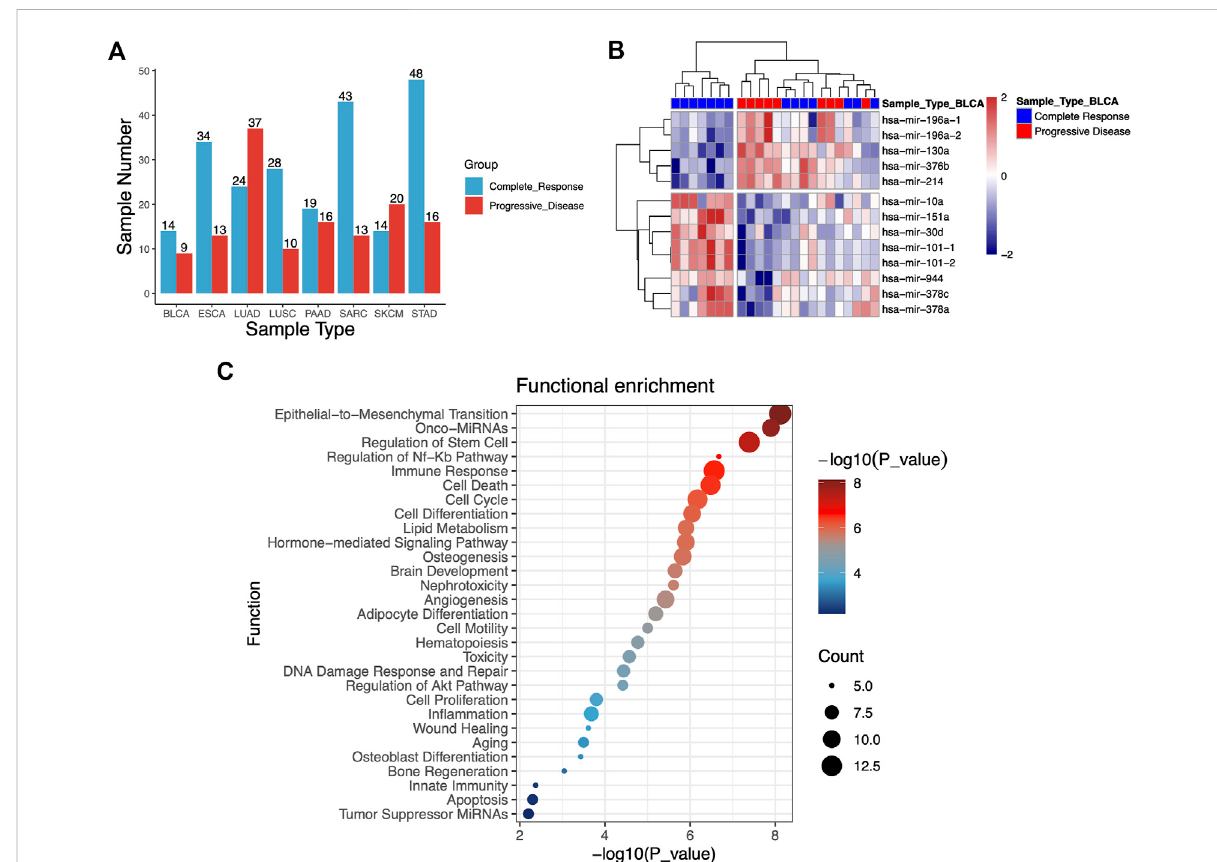
FIGURE 1 (A) Statistical histogram of cancer types of samples and grouping. The samples of cancer patients were categorized into complete response (S) group and progressive disease (R) group depending on their clinical response to RT treatment. A total of 358 tumor samples across eight different types of human cancers fromTCGA databaseare analyzed. (B) Heatmap of13 miRNAs that weredifferentially expressedfrom Sand R samples inthe bladder urothelial carcinoma (BLCA). (C) Functional enrichment analysis of 47 differentially expressed